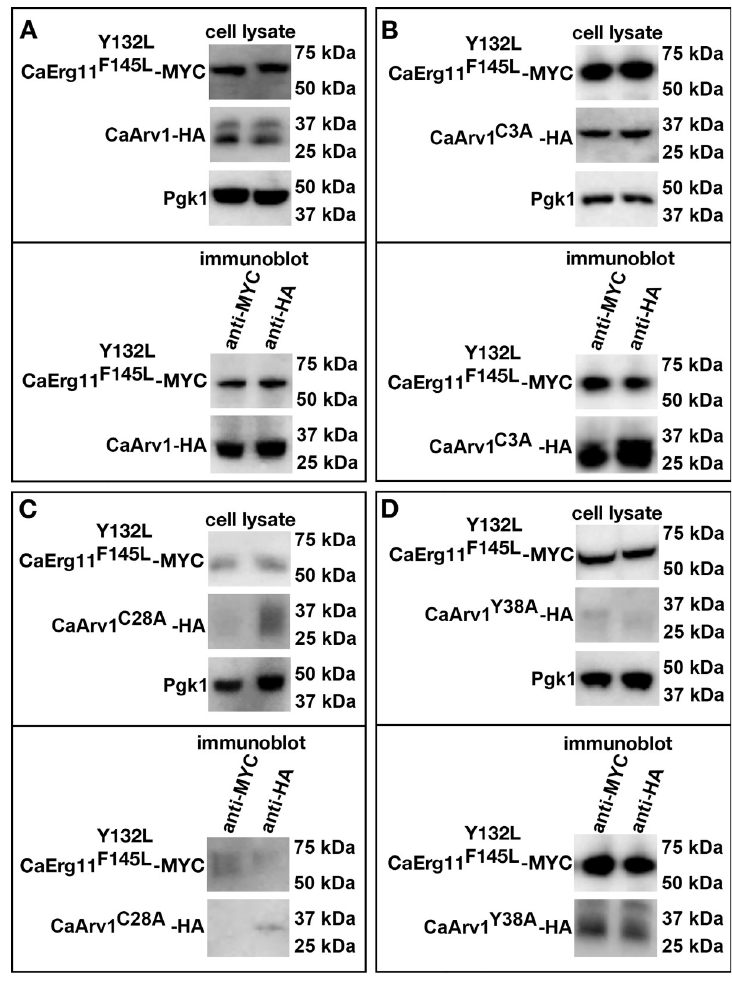
Fig 9. CaArv1 C28A is unable to co-immunoprecipitate with CaErg11 Y132L F145L . Scarv1 cells co-expressing CaArv1-HA mutants and wild type CaErg11 Y132L F145L -MYC were grown to exponential phase in the appropriate plasmid selection medium. (A-D), represents the co-immunoprecipitation western results using the indicated anti- MYC antibodies or anti-HA antibodies and indicated Arv1 mutants (immunoblot). The cell lysate panels represent the total Erg11-MYC or Arv1-HA protein levels in total cell lysates. The panels represent data from 3 individual experiments. The differences in detection seen are due to the use of protein lysates from steady state cells. The panels represent data from 3 individual